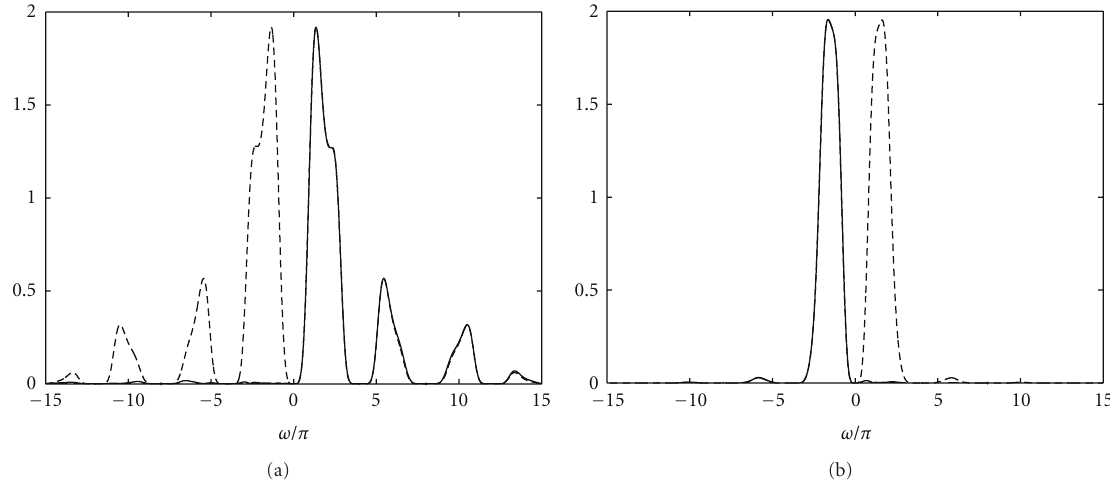
Figure 3: Magnitude responses of wavelet bases in Example 1. (a) Magnitude responses of decomposition wavelets: | Ψ h ( ω ) + i Ψ g ( ω ) | (the solid line) and 2 | Ψ h ( ω ) | (the dashed line). (b) Magnitude responses of reconstruction wavelets: | (cid:2) Ψ h ( ω )+ i (cid:2) Ψ g ( ω ) | (the solid line) and 2 | (cid:2) Ψ h ( ω ) | (the dashed line).